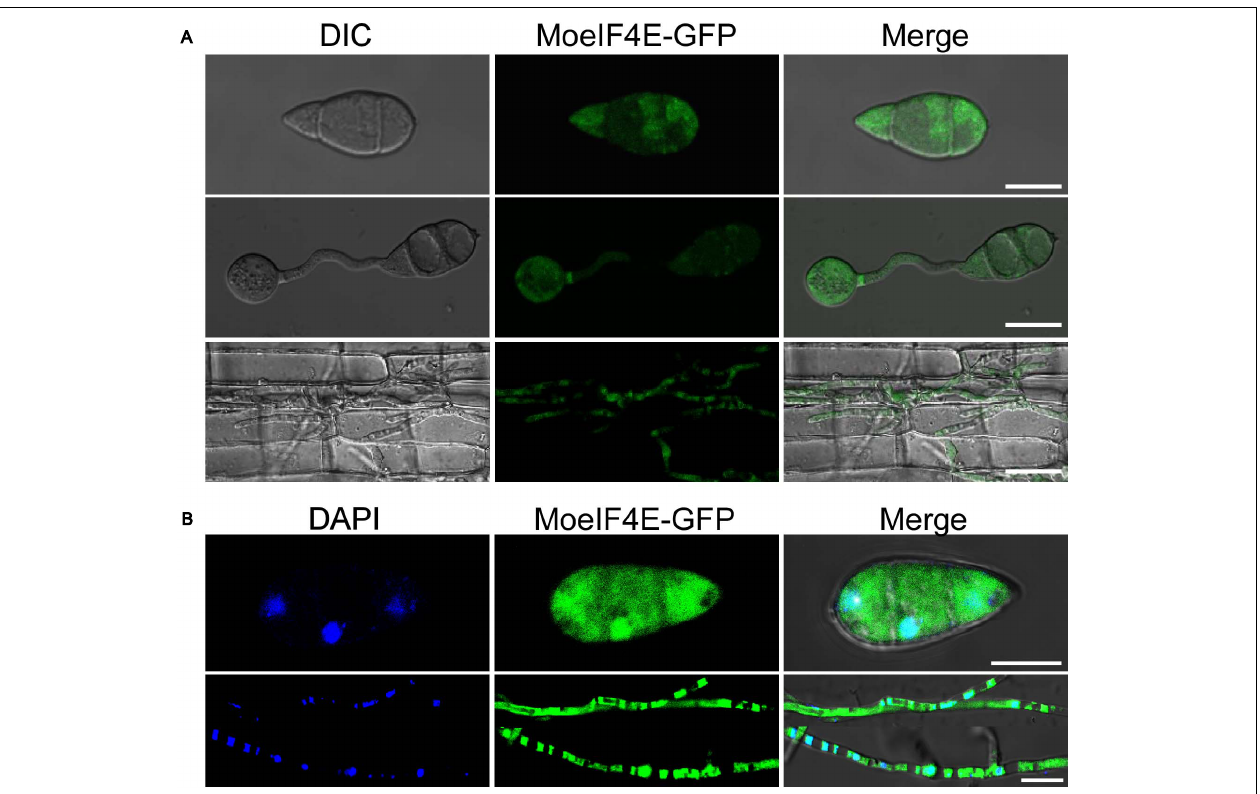
FIGURE 3 | Subcellular localization of MoeIF4E3 in M. oryzae and in planta . (A) The localization pattern of MoeIF4E3 in asexual spore, during spore germination and in invasive hyphae during plant infection. (B) Localization pattern of MoeIF4E3 with DAPI staining in asexual spore and invasive hyphae. Localization of MoeIF4E3-GFP was visualized using Nikon laser confocal microscopy. The scale bar is 20 and 40 µ